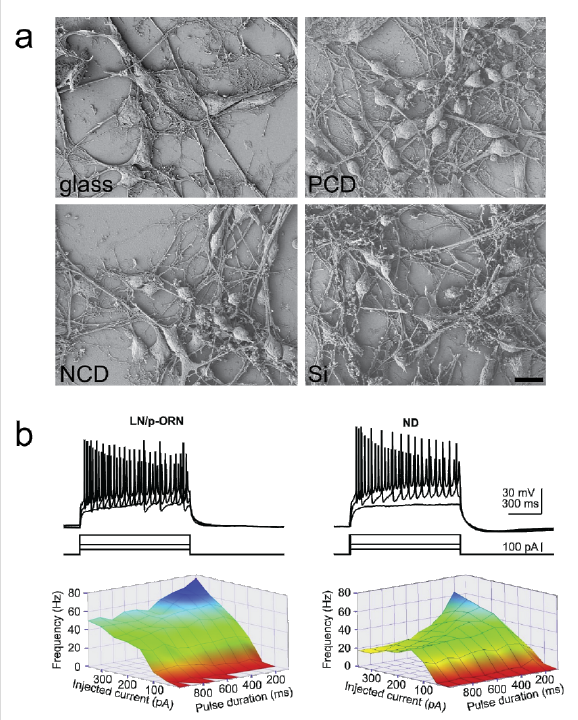
Figure 5: Sketch of the device for recording the extracellular electrical activity of cultured neuronal networks, developed by Ariano and co-workers. Cells (4) are plated in the recording chamber (8), directly onto hydrogen-terminated diamond (5). Reproduced from [128] with permission. Copyright 2009